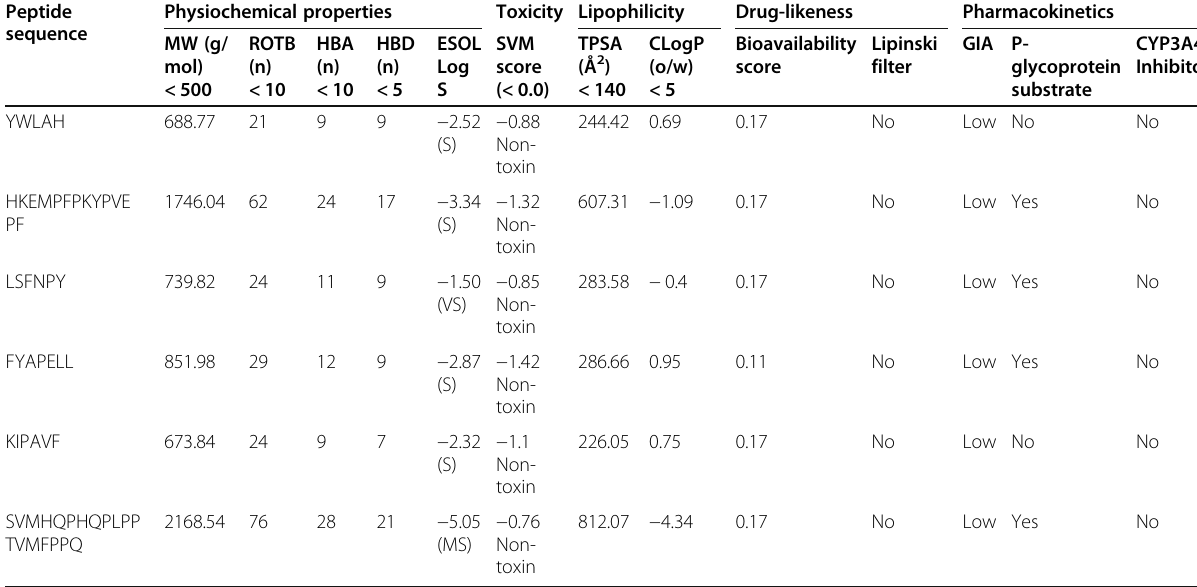
Table 2 In silico absorption, distribution, metabolism, excretion and toxicity (ADME/Tox) profile of whey protein-derived zinc- binding peptides (Continued) Peptide Physiochemical sequence